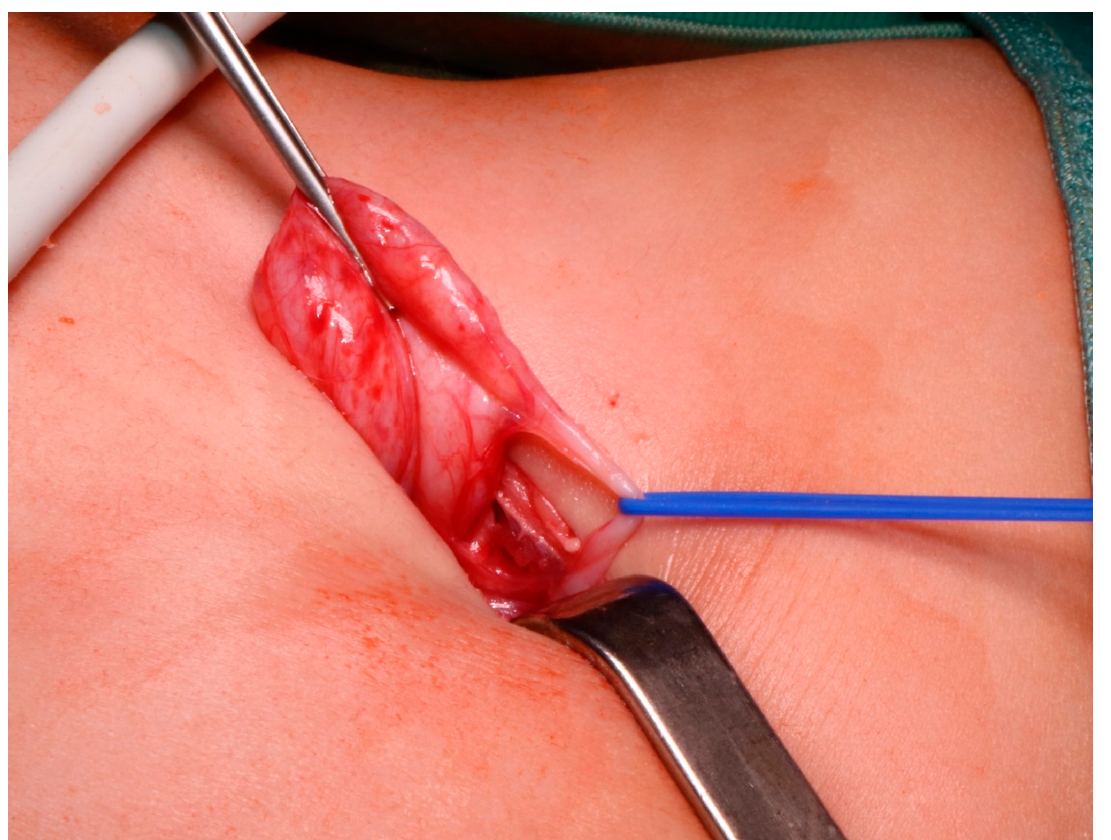
Figure 3. The UPJ is brought out through the lumbar incision using a vessel loop, inserted during the retroperitoneoscopic phase.